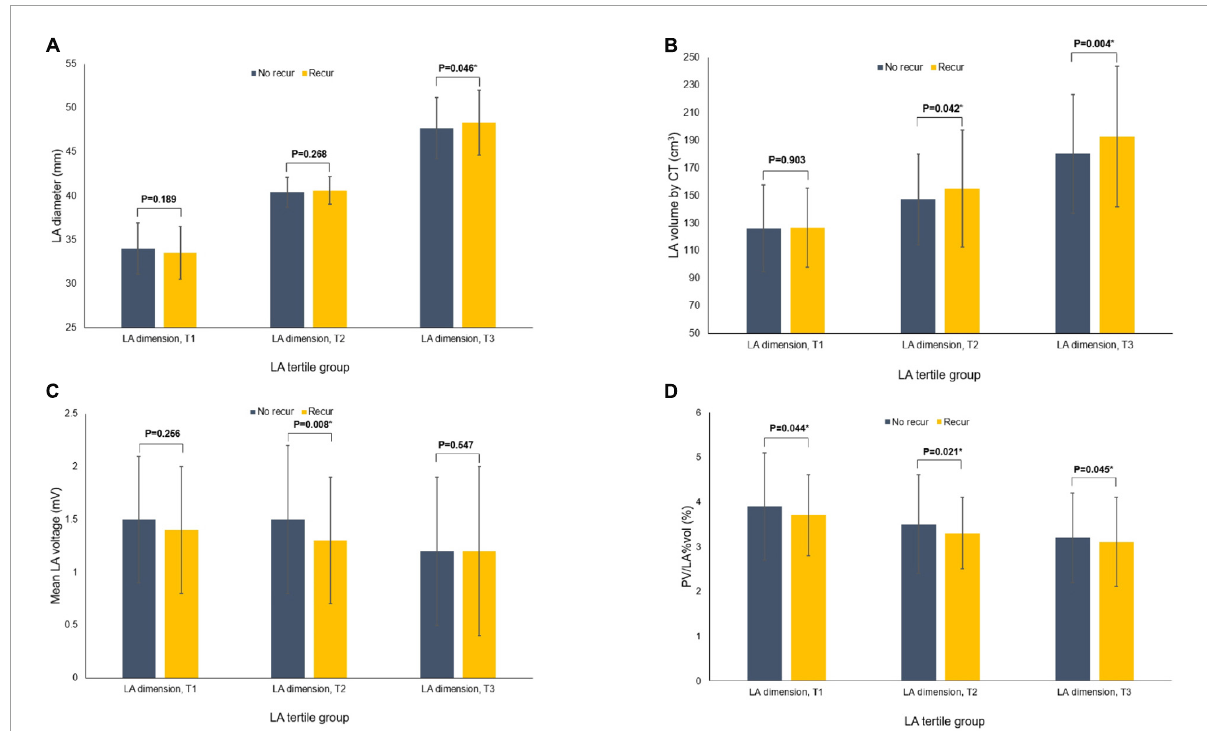
FIGURE1 Comparisons of the variables according to the recurrence of AF at 1-year after the AFCA among the tertile groups of LA dimension. Comparisons of the LA dimension (A) , CT-measured LA volume (B) , mean LA voltage (C) , and PV/LA%vol (D) . AF, atrial fibrillation; AFCA, atrial fibrillation catheter ablation; CT, computed tomography; LA, left atrium or left atrial; PV, pulmonary vein; PV/LA%vol, pulmonary vein to left atrium volume percent ratio.